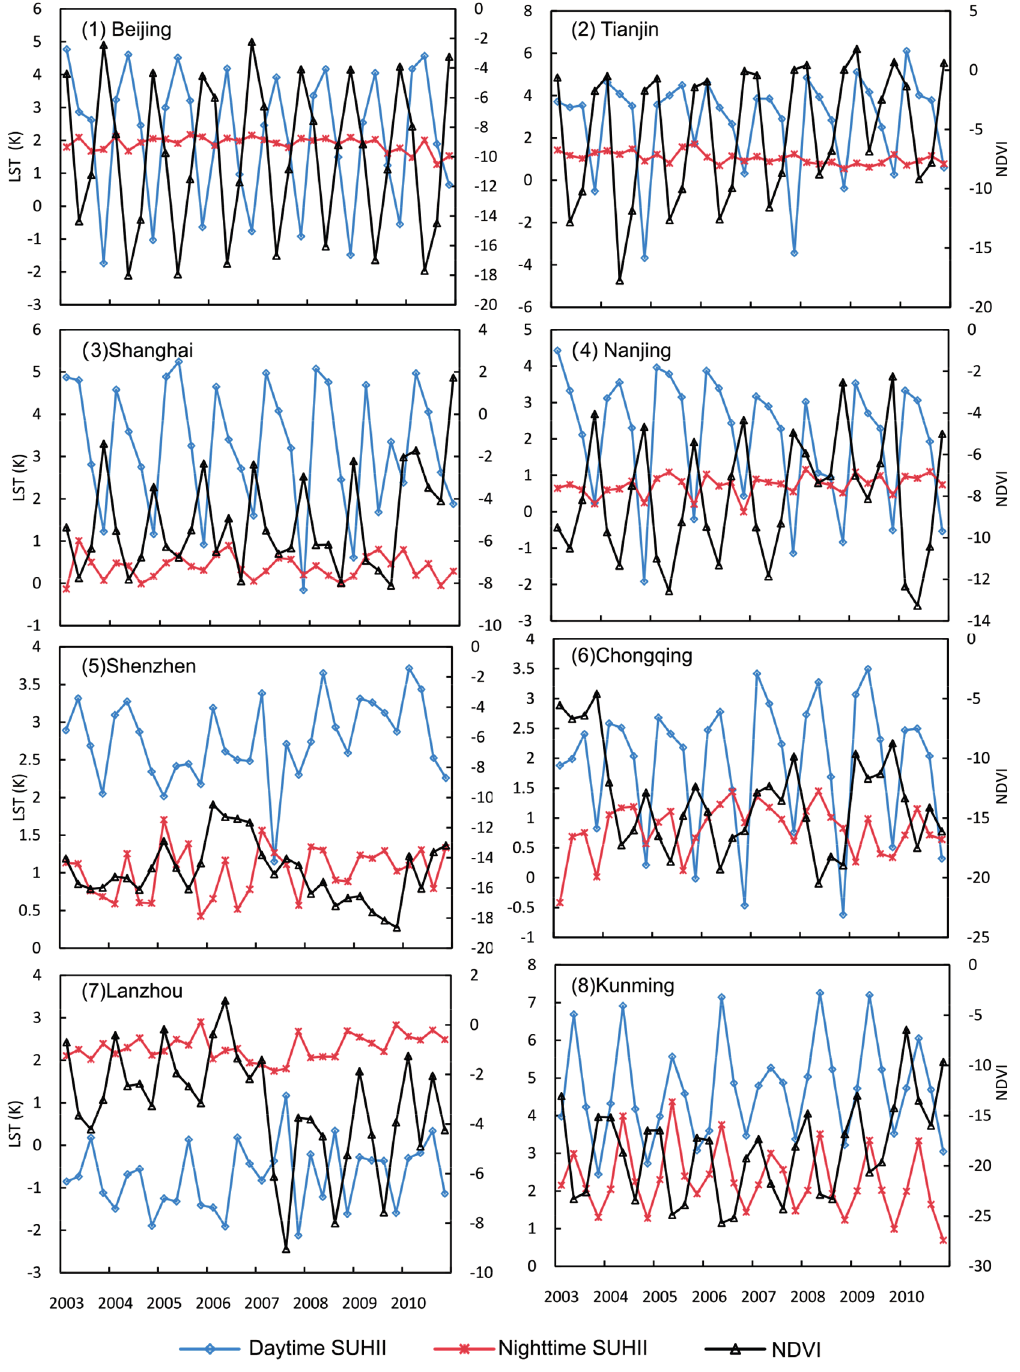
Figure 4. The seasonally averaged SUHII and NDVI from 2003 to 2010 for eight typical cities: ( 1 ) Beijing; ( 2 ) Tianjin; ( 3 ) Shanghai; ( 4 ) Nanjing; ( 5 ) Shenzhen; ( 6 ) Chongqing; ( 7 ) Lanzhou; ( 8 ) Kunming. The locations of these cities are shown in Figure